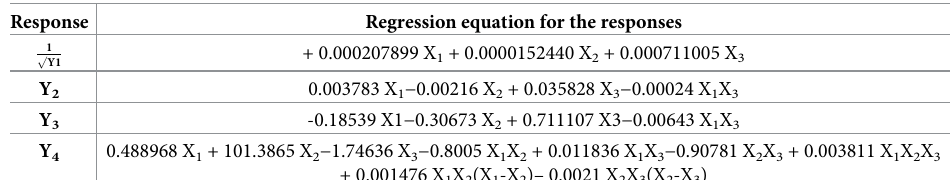
Table 2. Regression results of the measured